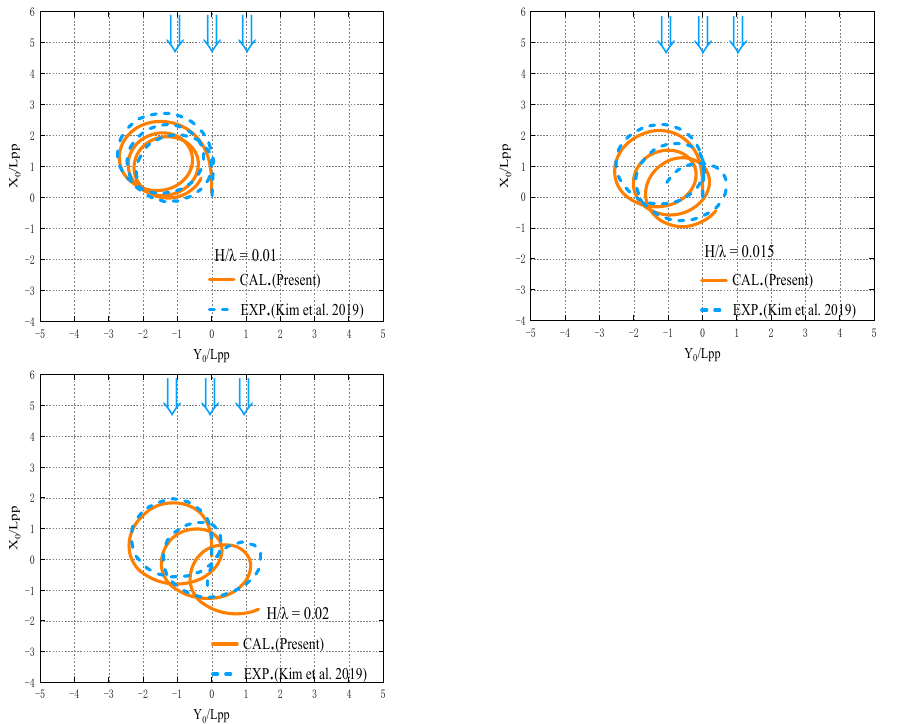
Figure 27. Comparisons of the turning trajectory of −35° turns with the variation of wave steepness in the head waves. The experimental values were reproduced from [8], with permission from Elsevier, 2022.